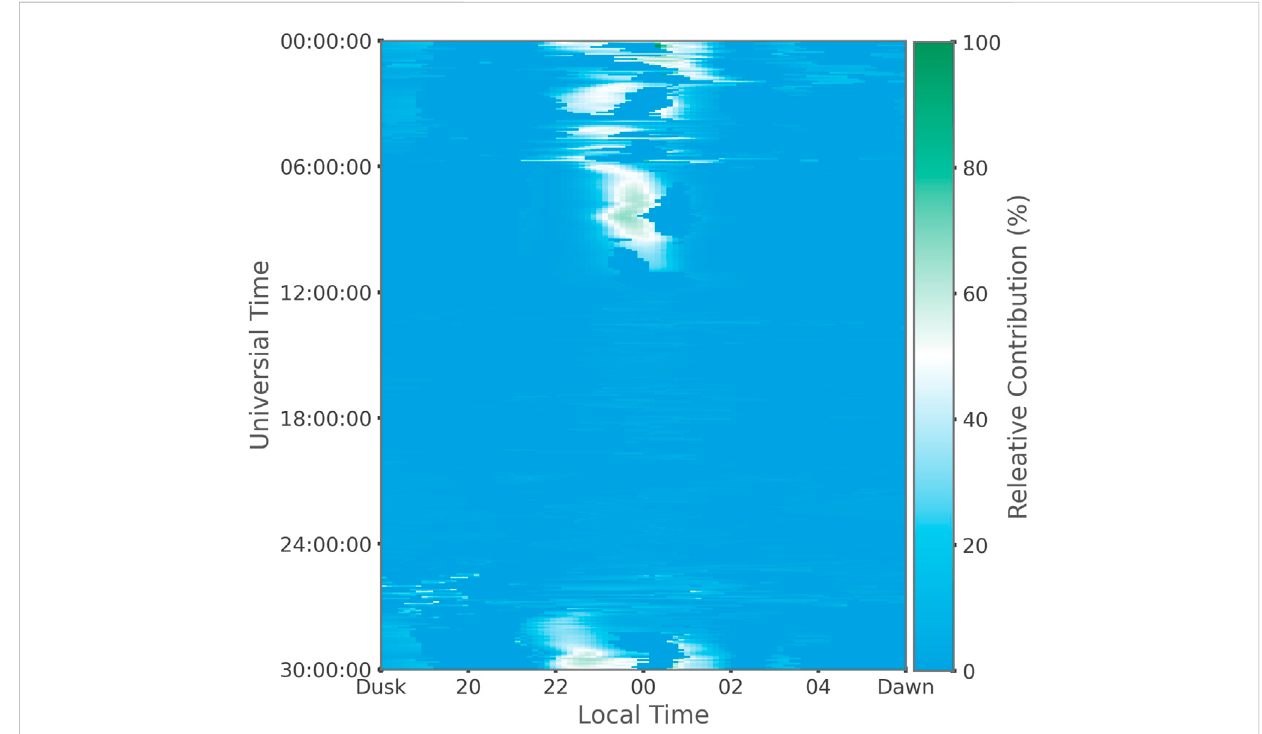
FIGURE 12 Relative contribution of the recirculating plasmasphere as a function of local time and simulation time in the Idealized CIR simulation. At 0% there is no recirculating plasmaspheric material. At 50% (white) the recirculating plasmaspheric material is contributing equally to the combined contributions of solar and polar winds. At 100% there is no contribution from the solar and polar